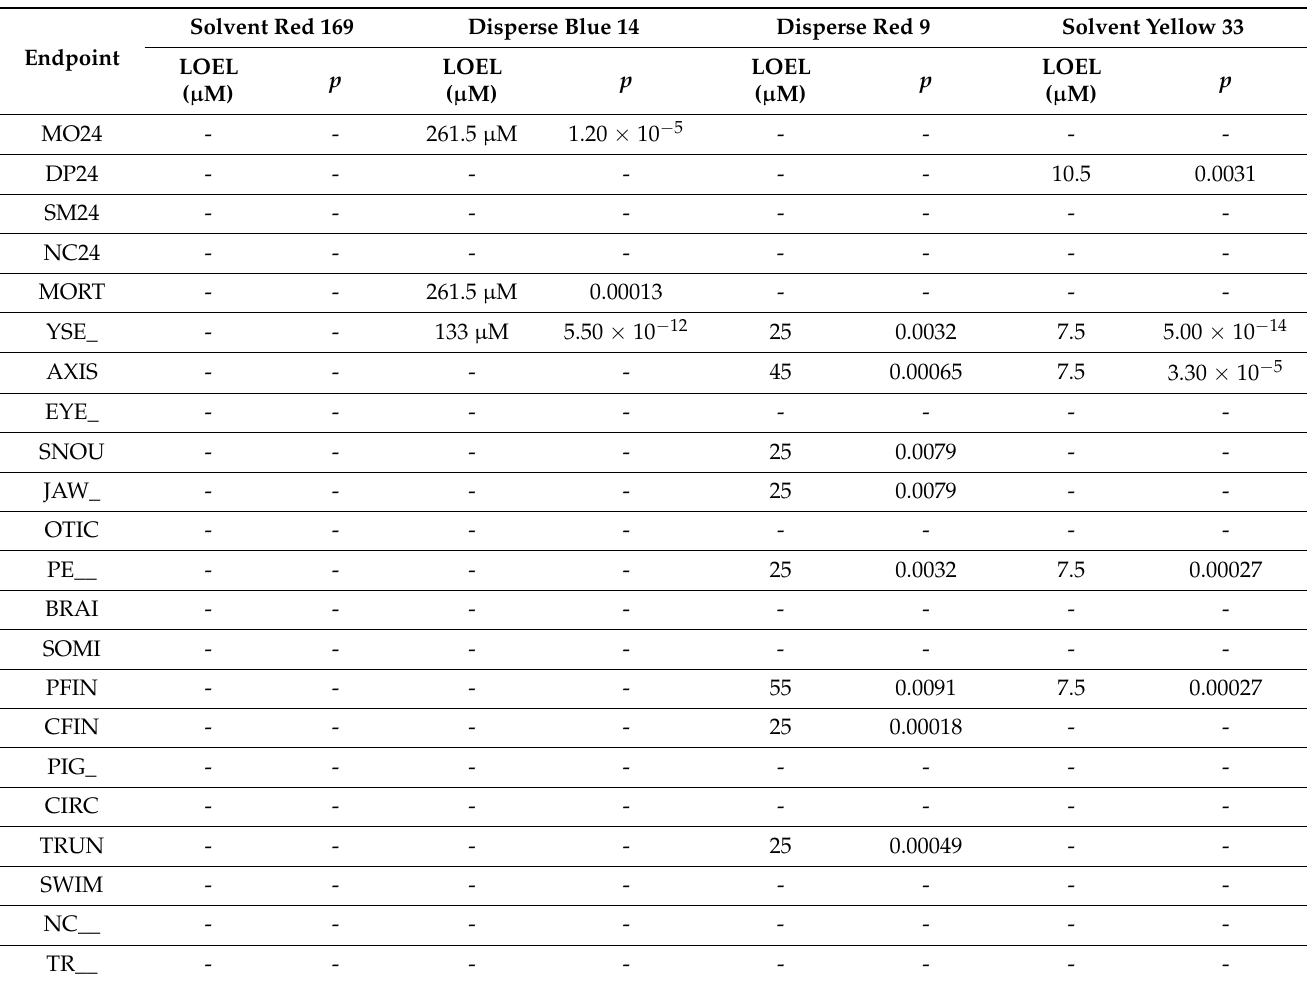
Table 2. Lowest Observable Effect Levels (LOEL) and Fisher’s Exact Test (P) p -values for morphologi- cal endpoints. (-) indicates no significance at any concentration. At 24 hpf, embryos were assessed for mortality (MO24), developmental progression (DP24), spontaneous movement (S24), and notochord distortion (NC24). Additionally, at 120 hpf, embryos were assessed for mortality (MORT), and morphological malformations including yolk sac edema (YSE), bent body axis (AXIS), eye (EYE), snout (SNOU), jaw (JAW), otic (OTIC), pericardial edema (PE), brain (BRAI), somite (SOMI), pectoral fin (PFIN), caudal fin (CFIN), circulation (CIRC), pigmentation (PIG), trunk length (TRUN), swim bladder (SWIM), notochord distortion (NC), and alterations in touch response (TR).